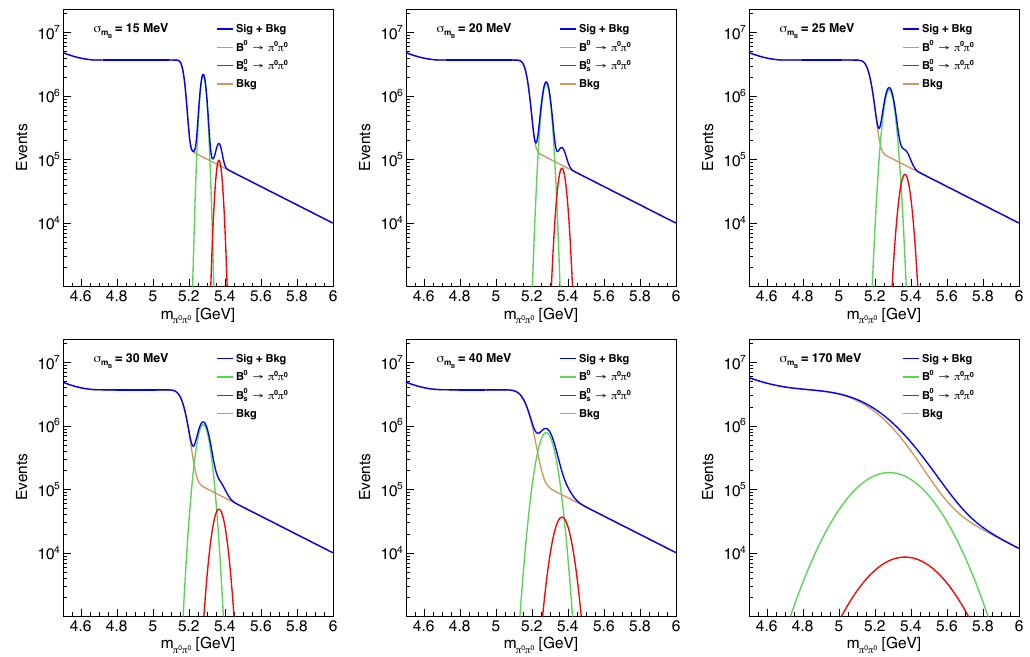
distributions of B 0 → π 0 π 0 , B 0 Figure 23 . m π 0 π 0 B -meson mass resolutions when applying the baseline b